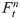
Evaluation on the scale dependency of accuracy measures.A: Synthetic time series data where Yt is the target series and Ftn are forecasts. Ft1 and Ft2 have the same mean absolute error, but errors are on different percentage scales to the corresponding values of Yt. B: Results of scale dependency evaluation, where MAE, RMSE, MASE and even GMRAE show no difference between Ft1 and Ft2. MRAE and MAPE produce substantially different errors for the two cases. sMAPE and UMBRAE can reasonably distinguish the two forecasts.